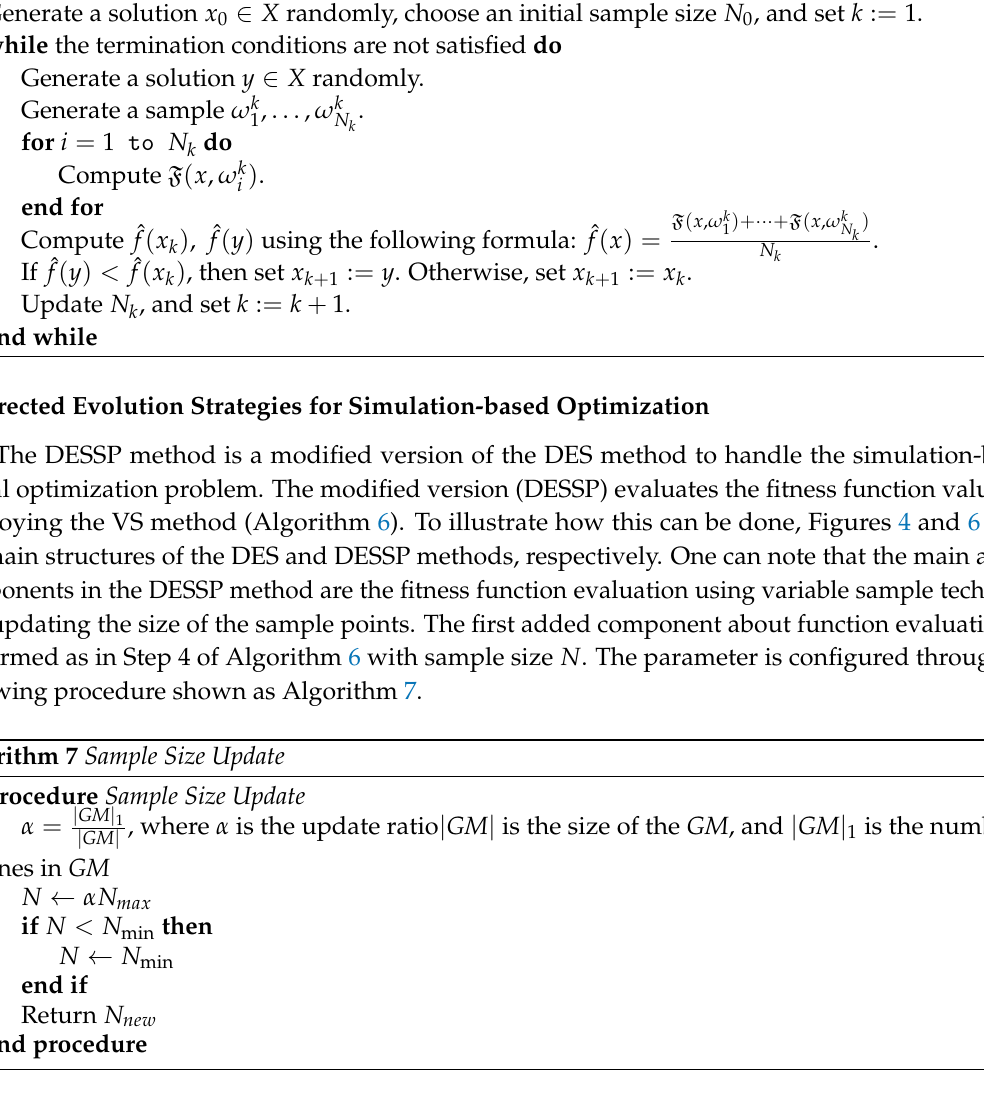
Algorithm 6 Sampling Pure Random Search (SPRS) Algorithm